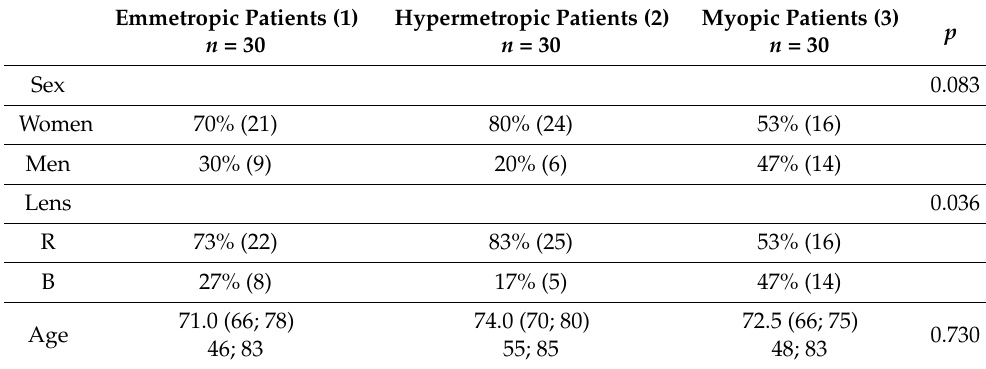
Table 1. Characteristics of the analysed group in terms of demographic data and treatment method. Emmetropic Patients